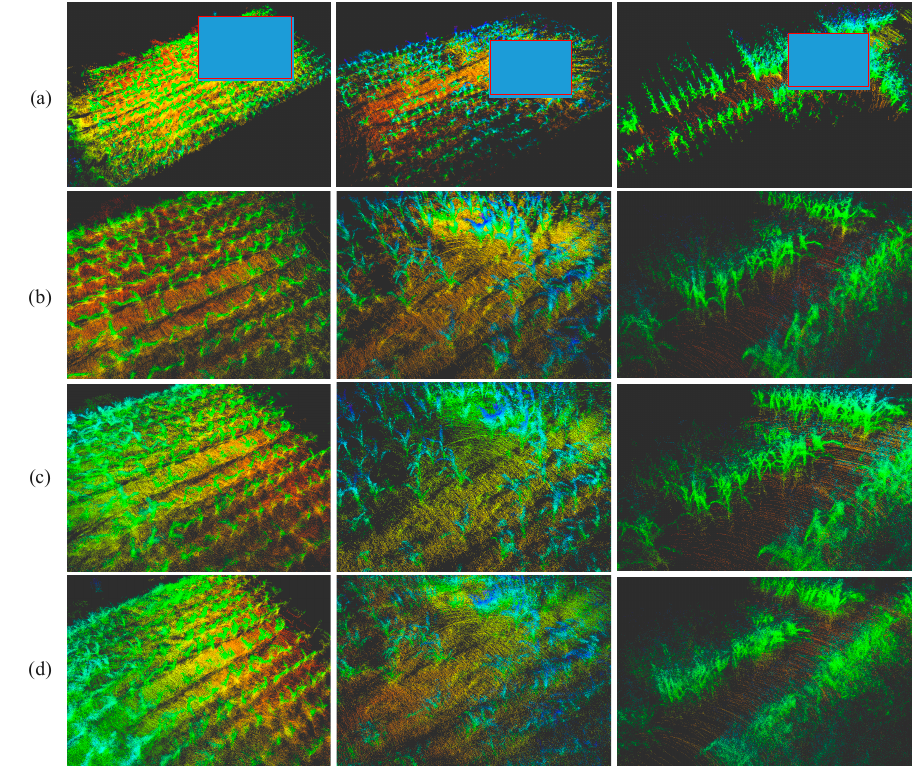
Figure 9. Maize maps generated by our method and other methods. ( a ) is the complete map obtained by our method; ( b ) is the details of the map obtained by our method; ( c ) is the same local detail obtained by the GICP method; ( d ) is the same local detail obtained by the LOAM.